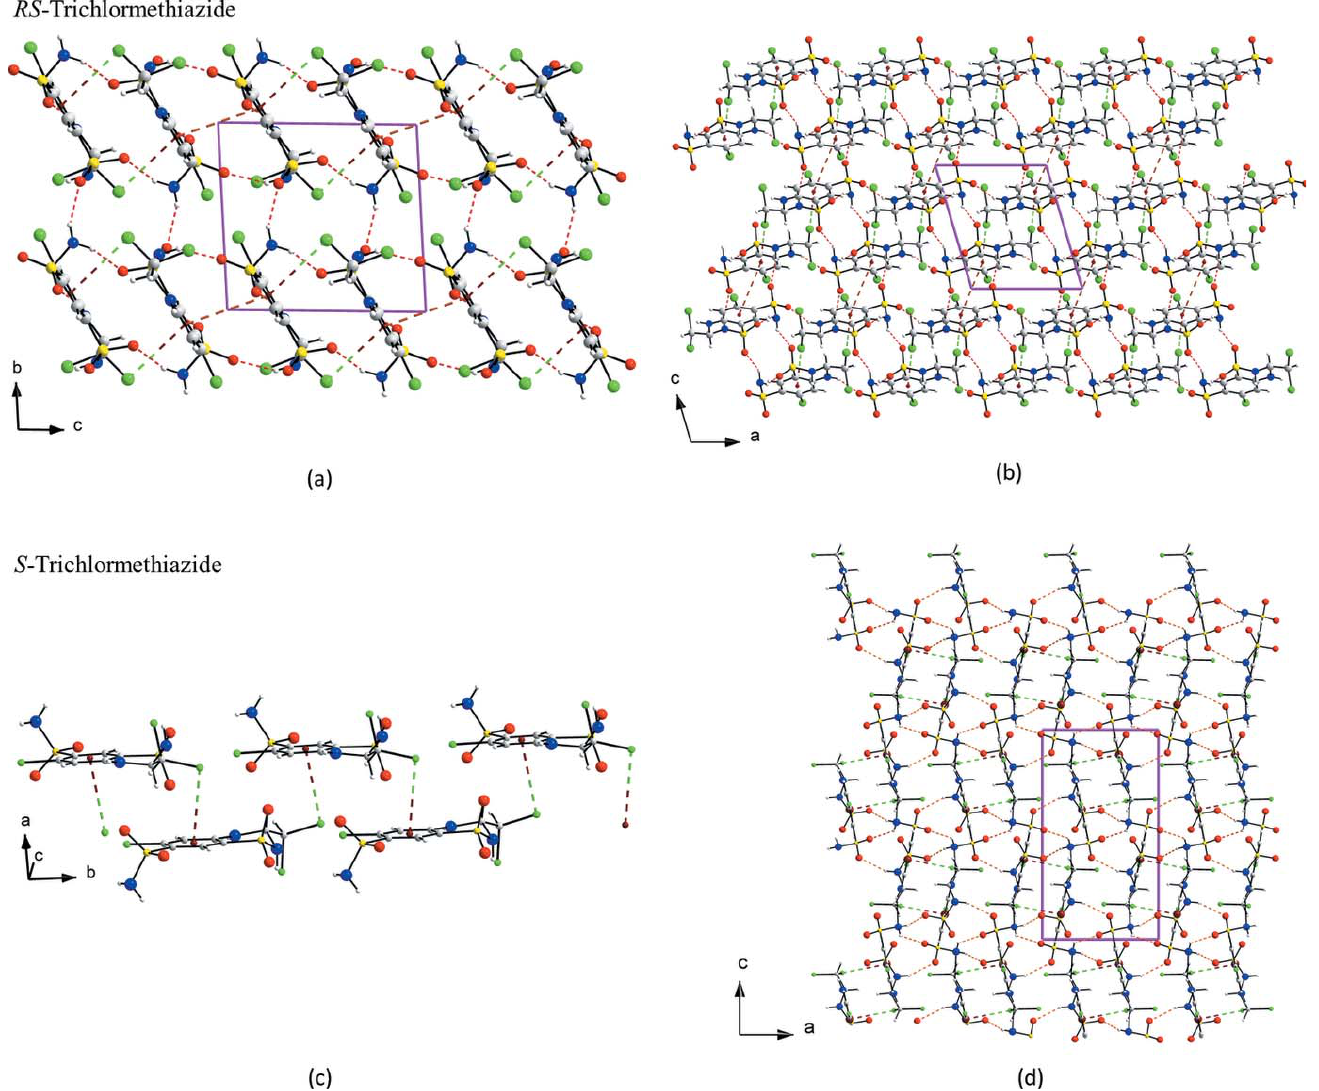
Figure 6 Packing arrangement of RS -TCMZ viewed ( a ) down the a axis and ( b ) down the b axis; (c) chains of S -TCMZ molecules connected by C—Cl (cid:2)(cid:2)(cid:2) (cid:3) interactions along the b axis; ( d ) view down the b axis of chains connected by N—H (cid:2)(cid:2)(cid:2) O and N—H (cid:2)(cid:2)(cid:2) N hydrogen bonds in S